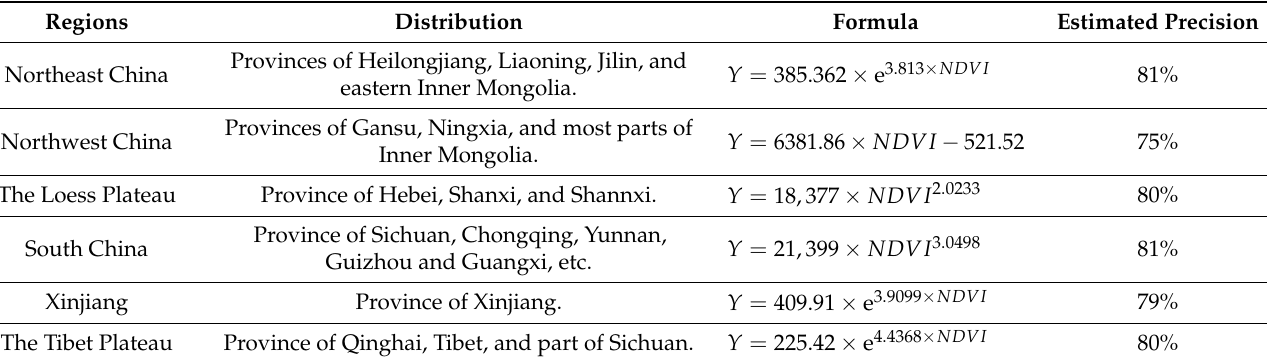
Table 1. Models calculating fresh grass yield (t DM ha − 1 yr − 1 ) in six regions in China [22]. Regions Distribution Formula Estimated